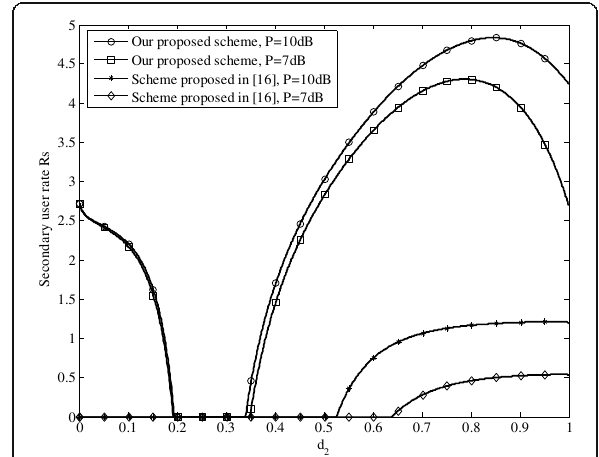
Fig. 5 Secondary user rate comparison versus d 2